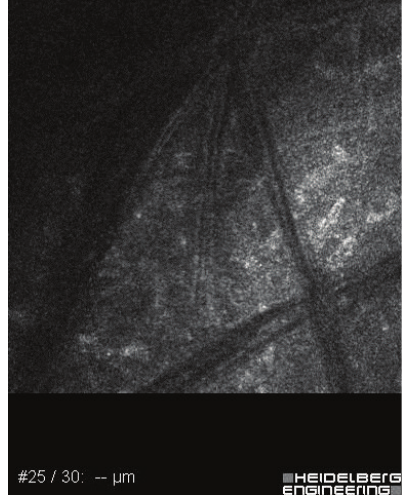
Figure 3: Confocal corneal examination revealing extreme corneal nerve thickening.